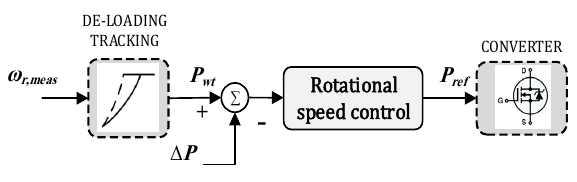
Figure 10. Rotational speed control.